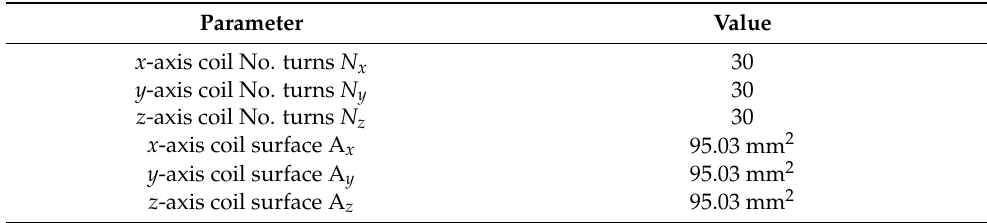
Table 1. 3D search coil parameters.